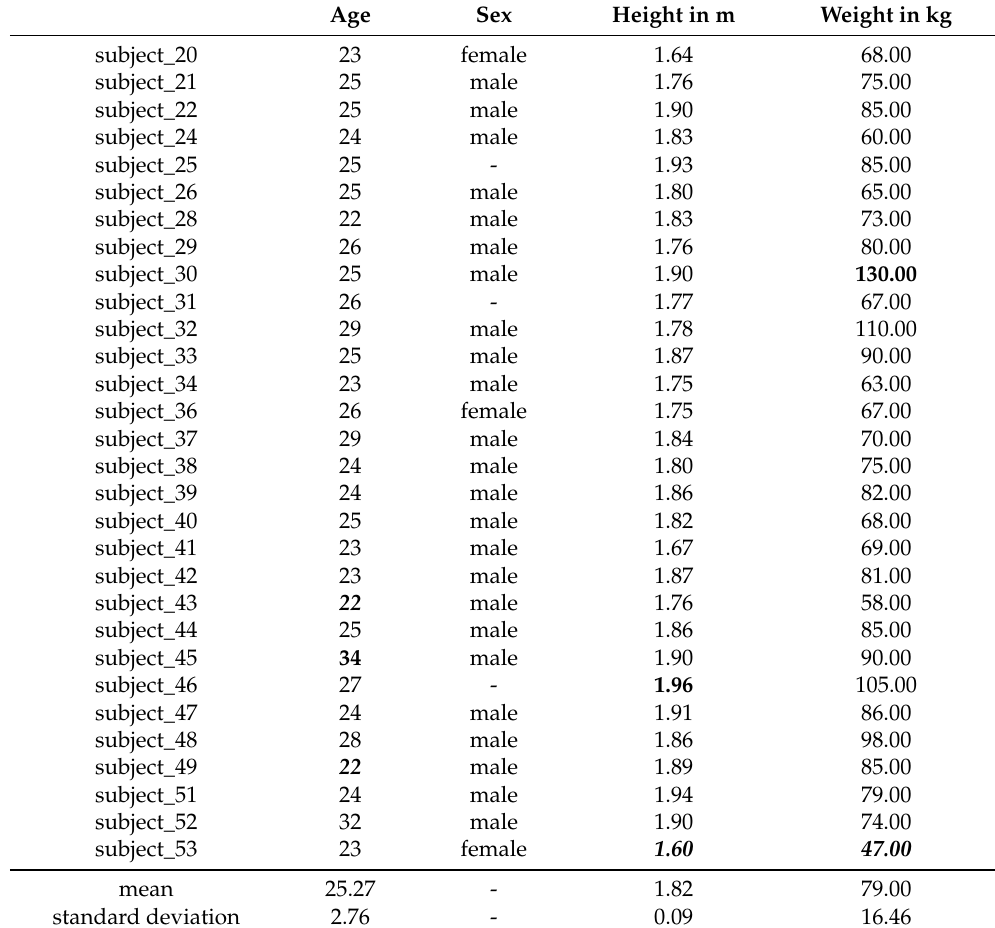
Table A1. Overview of all subjects. Ages are given in whole years. All information is based on the statements of the individual subject. Maxima are marked in bold and minima in bold and italic.